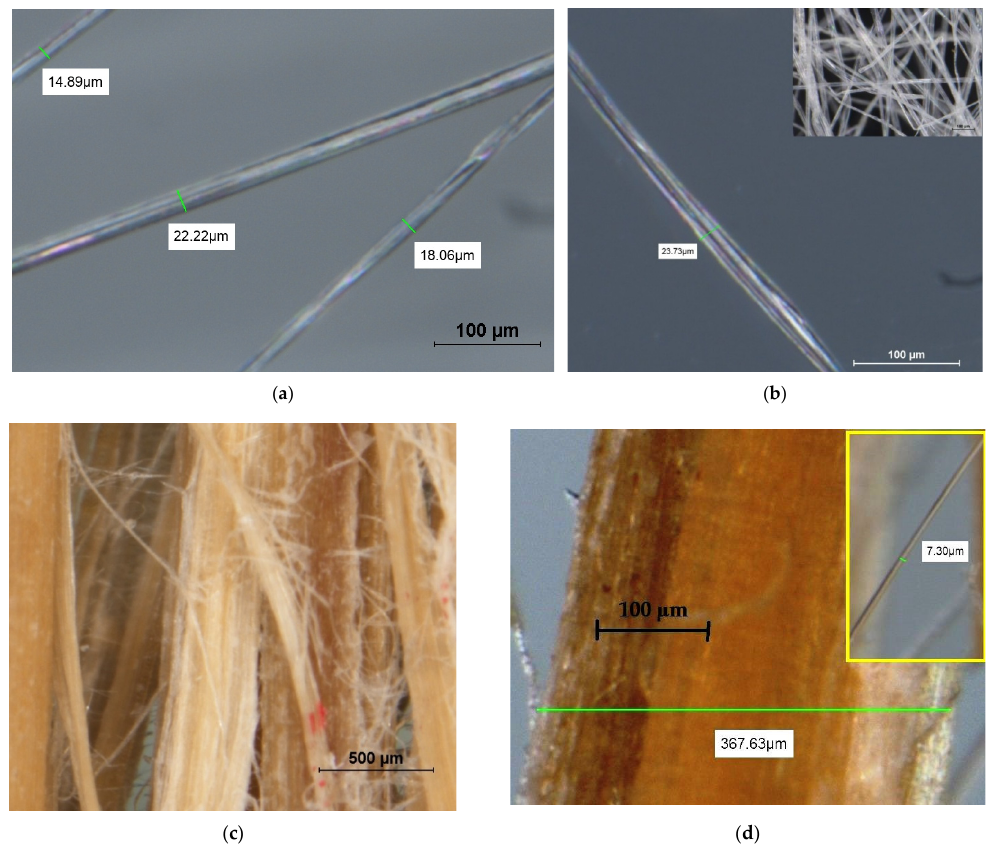
Figure 5. Microscopic investigation of the fibres: ( a ) untreated Calotropis fibres (240× magnification); ( b ) treated Calotropis fibre (240× magnification); ( c ) date-palm fibres (60× magnification); ( d ) meas- ured bundle of date-palm fibres and the measured diameter of the single fibre in the detail image (240× magnification).